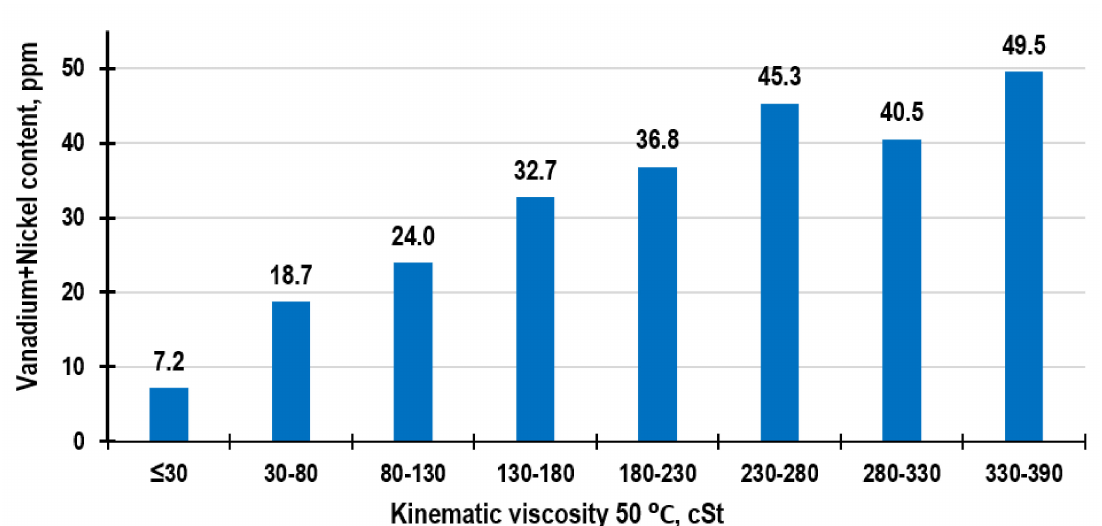
Figure 6. Dependence of the total vanadium and nickel content on the kinematic viscosity of the fuel in the averaged form